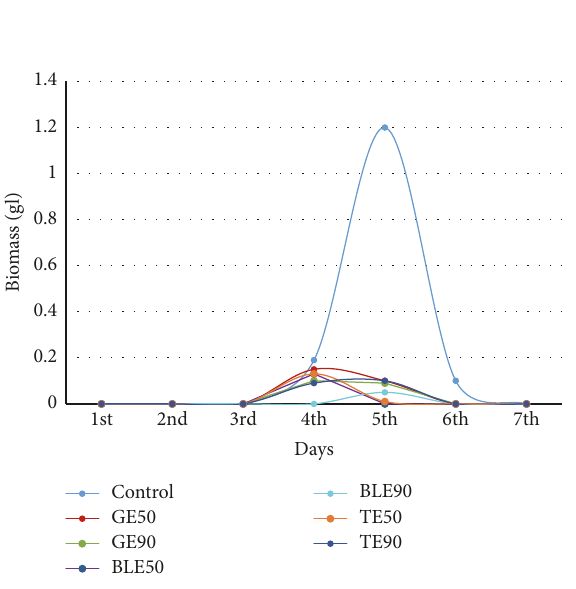
Figure 2: Effects of biocides concentration on the planktonic biomass. The culture was grown for day seven, and the biocides were injected on day three.